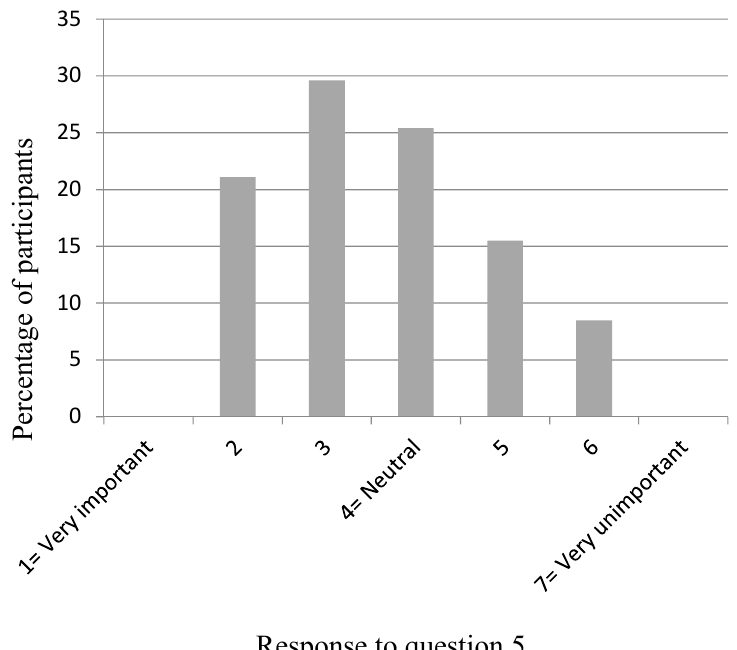
Figure 4. Participants’ response to Question 5: “How important do you perceive the values (beliefs, priorities, preferences) of the edentulous patient’s family or friends to be in making treatment decisions?”